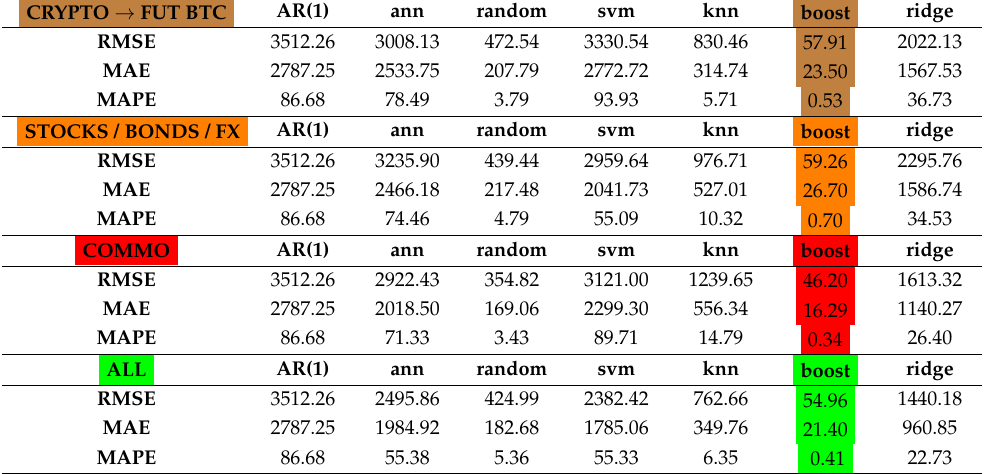
Table 7. Sub-sample with the Introduction of Tether (USDT): Forecasting of the CME Bitcoin Fu- tures